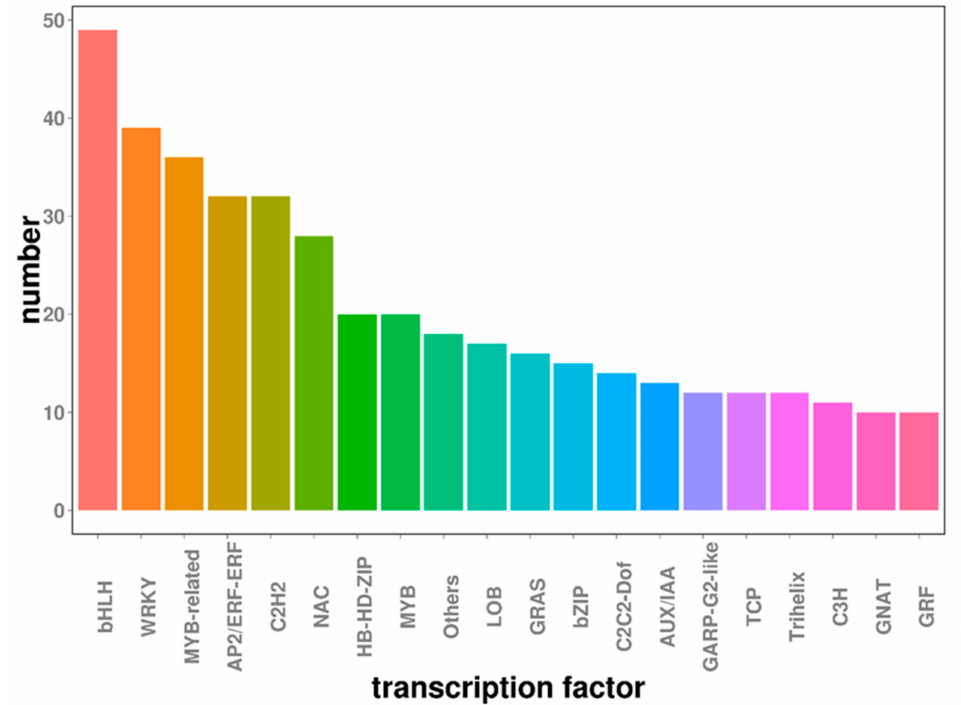
Figure 6. Transcription factors involved in embryogenic callus